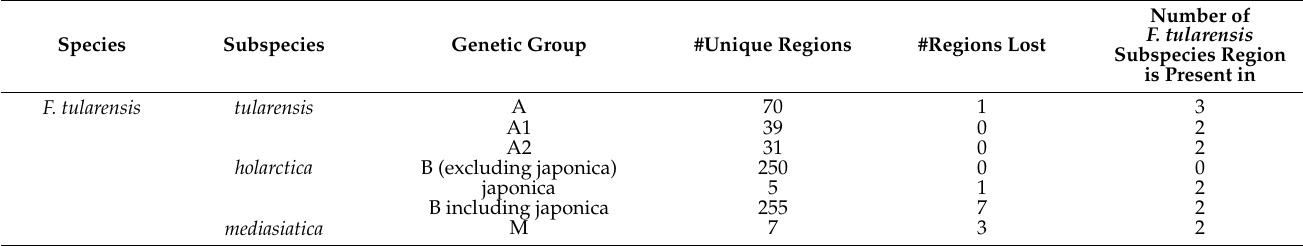
Figure 4. Visualization of genomic regions that are differentially present/absent across the three subspecies of F. tularensis and/or major phylogenetic groups within the subspecies. A phylogeny is presented in the middle of the figure, and the multiple circles around the phylogeny correspond to different genomic regions. The color of each cell in the circles corresponds to the BSR value for each genomic component in each examined whole genome sequence. Table 4. Number of genomic regions that are unique to or have been lost across the three subspecies of F. tularensis and/or major phylogenetic groups within the subspecies.